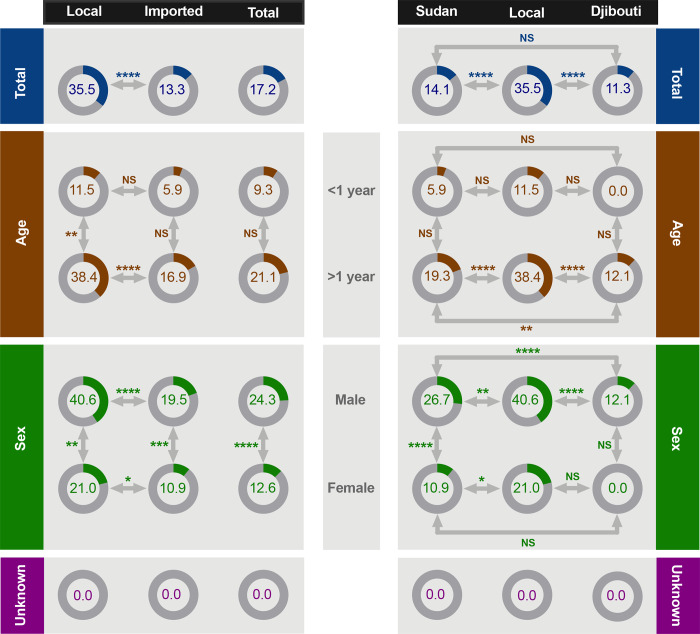
RNA detection rate in imported and local dromedary camels based on age and sex.Percentage of seroprevalence is shown for each category. ****p<0.0001, ***p <0.001, **p <0.01, *p <0.05 and NS denotes not statistically significant (Fisher Exact Test).